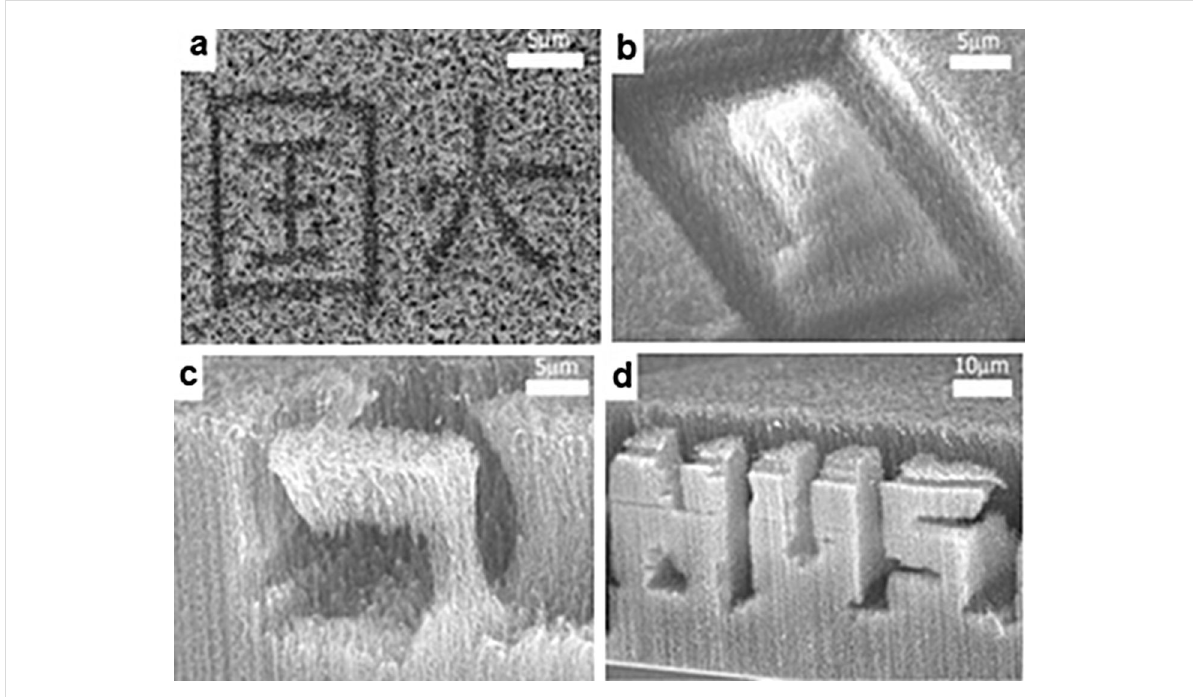
Figure 7: SEM images of (a) Chinese characters cut in 2D on a mat of CNTs, (b) a pyramidal structure cut by focusing the laser to different depths and scanning over the predetermined areas, (c) an inverted “L”, and (d) 3D letters “NUS” produced in a two-step process: cutting first from the side and then with the sample in face-up configuration. Adapted with permission from [73]. Copyright 2003 John Wiley and